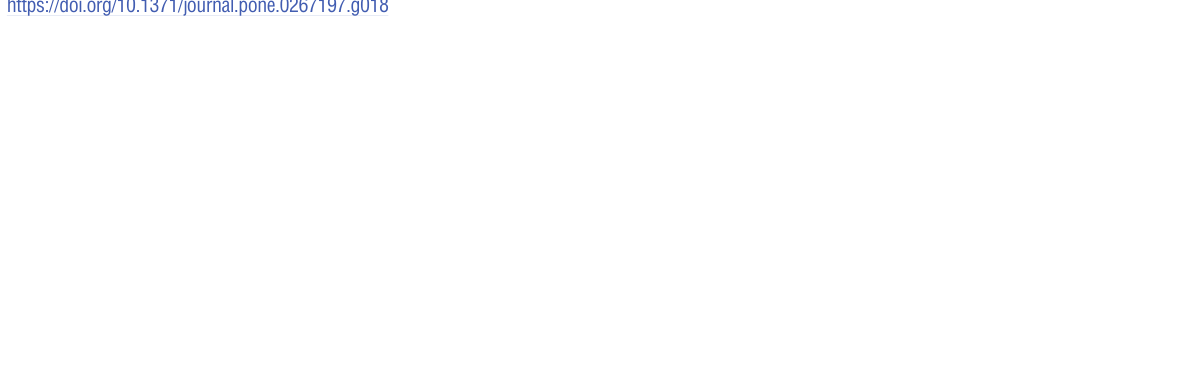
PLOS ONE | https://doi.org/10.1371/journal.pone.0267197 May 2, 2022 20 /